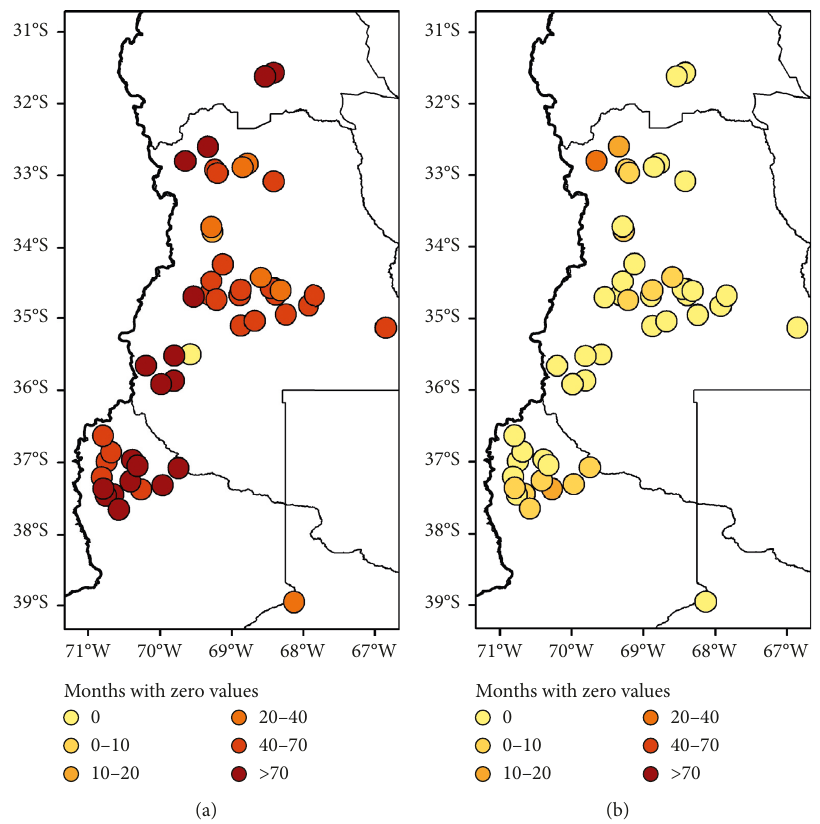
Figure 7: Frequency of zero precipitation months for each (a) rain gauge (RG) and (b) CHIRPS